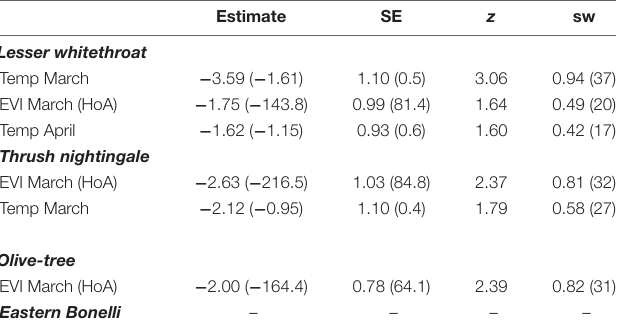
Variables were standardized, and non-standardized coefficients are also presented in brackets. EVI was calculated on the pre-migratory site and temperatures were measured at the stopover destination. For Eastern Bonelli, the null model (no predictors) was the average model. HoA, Horn of